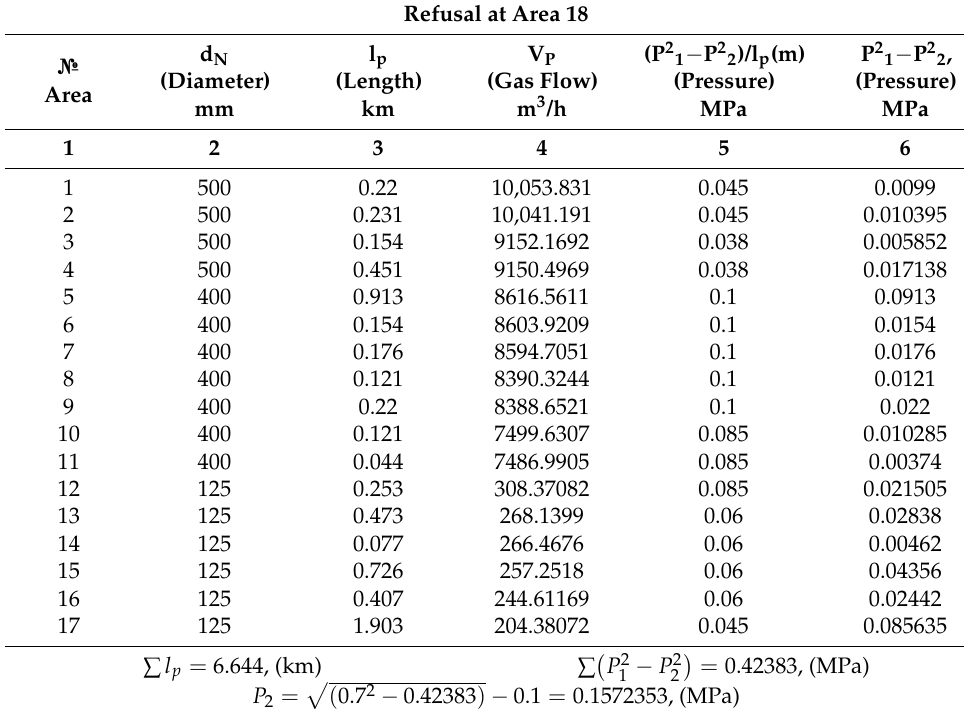
Table 5. Emergency mode at area